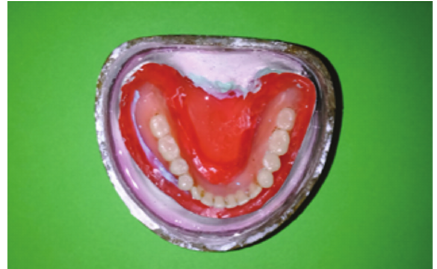
Figure 9: Invested mandibular denture.